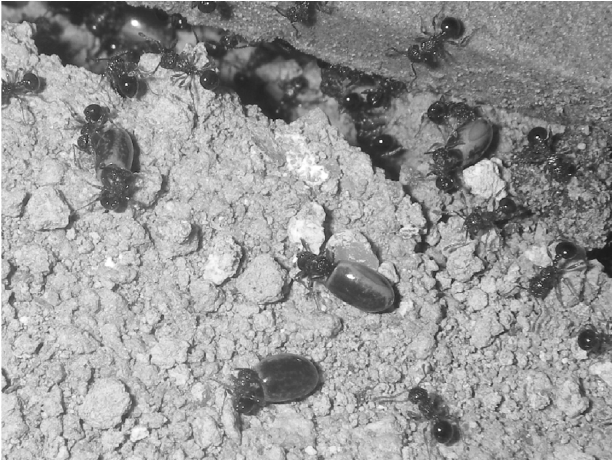
Fig 3 . Photograph of Pristomyrmex punctatus workers transferring Phraortes illepidus